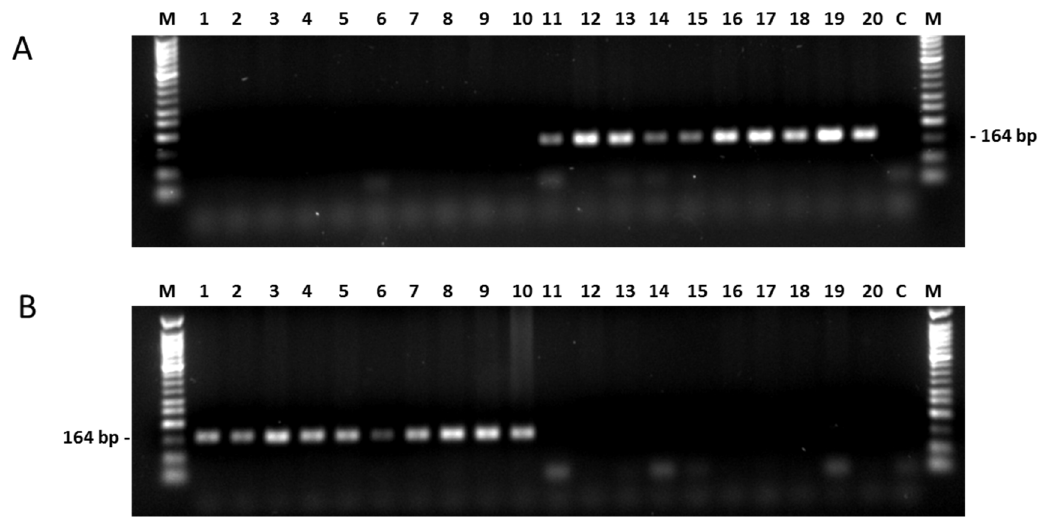
Figure 6. SNP markers PPR621.5M and PPR621.5R derived from PPR621 . ( A ) Marker PPR621.5M for the maintainer lines. ( B ) Marker PPR621.5R for the restorer lines carrying the Rf1 gene. 1 = RHA-282, 2 = UGA-SAM1-012, 3 = UGA-SAM1-024, 4 = UGA-SAM1-100, 5 = UGA-SAM1-121, 6 = UGA-SAM1-136, 7 = UGA-SAM1-169, 8 = UGA-SAM1-186, 9 = UGA-SAM1-191, 10 = UGA-SAM1-198, 11 = Arrowhead, 12 = CM104, 13 = CM526, 14 = Krasnodarets, 15 = UGA-SAM1-082, 16 = UGA-SAM1-109, 17 = UGA-SAM1-110, 18 = UGA-SAM1-140, 19 = UGA-SAM1-183, 20 = UGA-SAM1-273, C = negative control, M = 50 bp marker New England BioLabs ® .